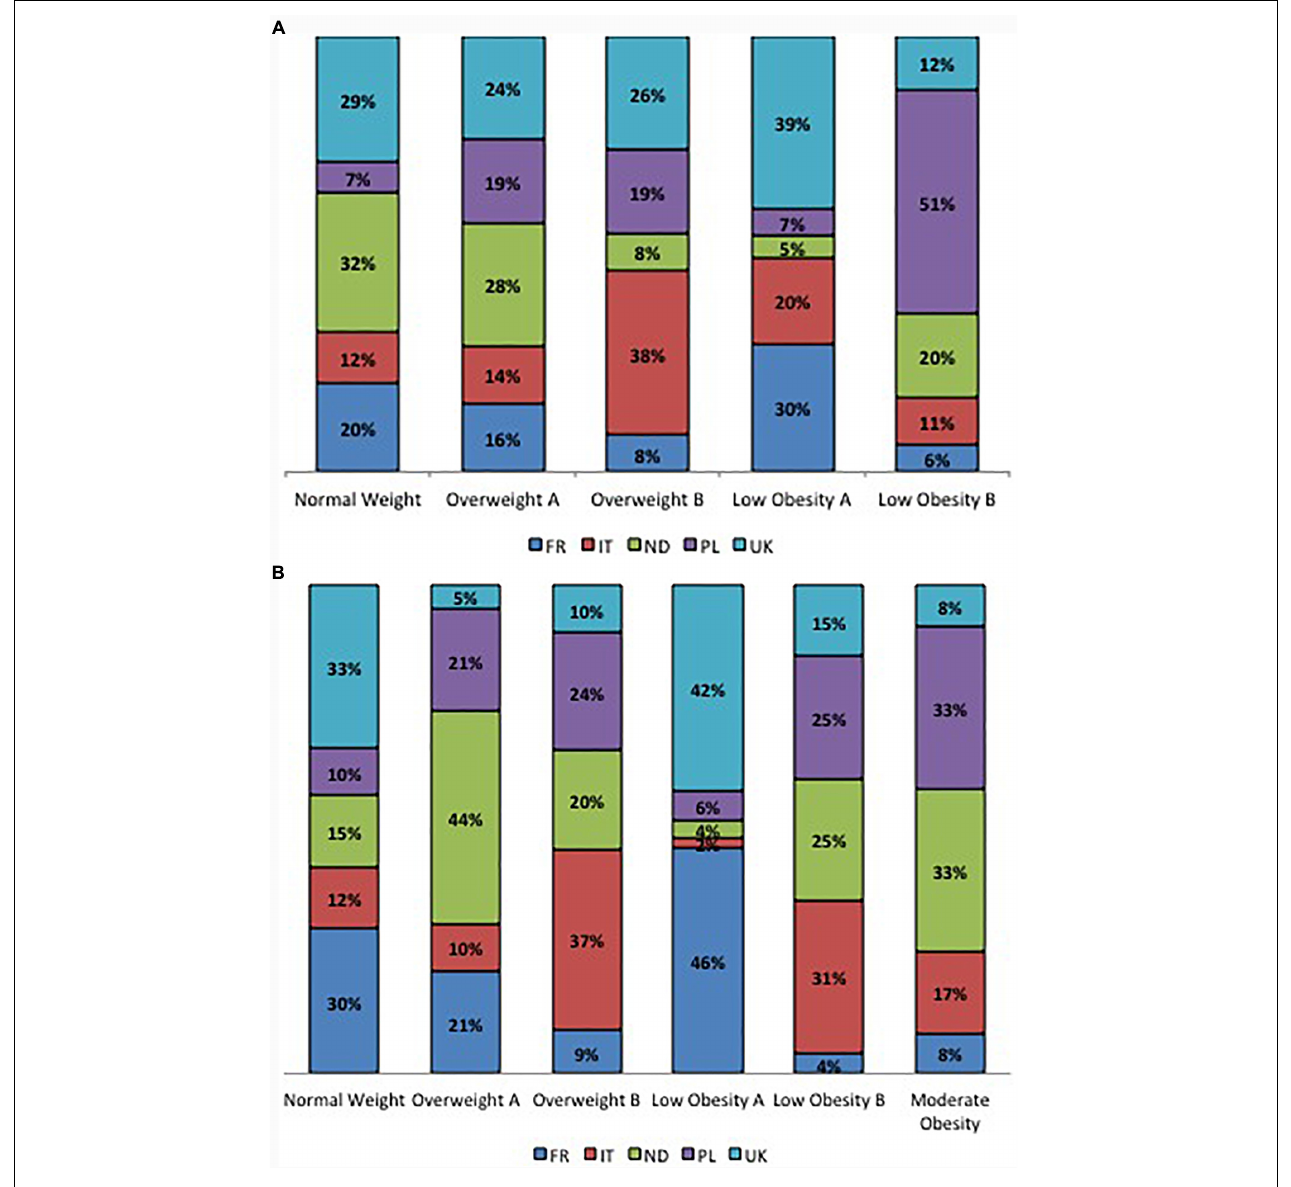
FIGURE 2 | (A) Percentage contribution of the countries to clusters in women. (B) Percentage contribution of the countries to clusters in men.